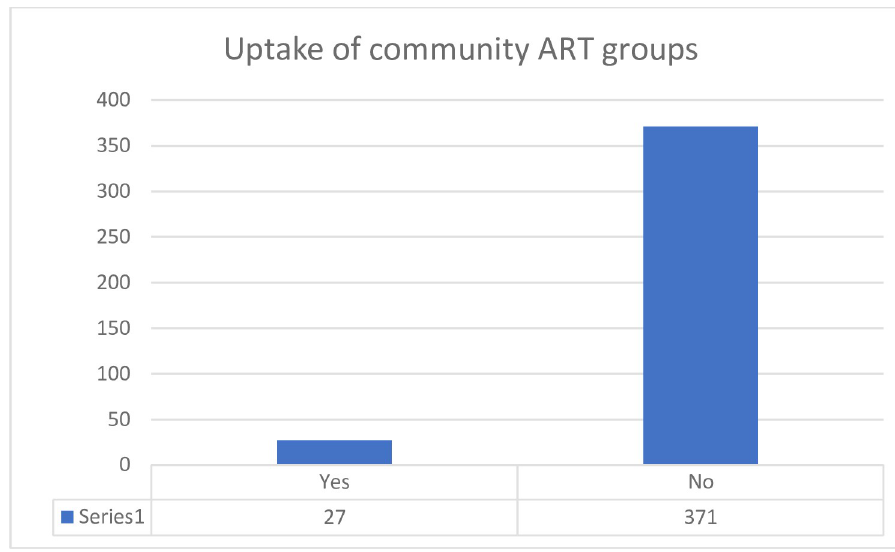
Fig 1. Bar graph showing uptake of community ART groups in Arua